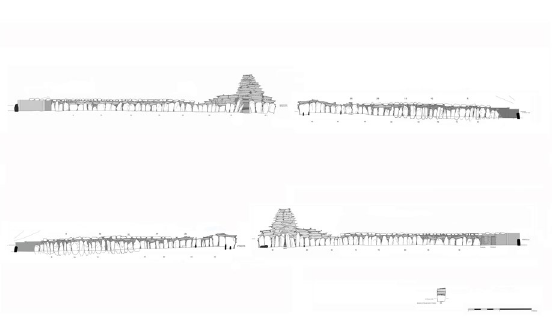
Figure 2. Elevation drawings of the eastern and western tombs contained within Site 1 at Knowth, Co. Meath (after Eogan and Cleary, 2017, Figure 2.3).